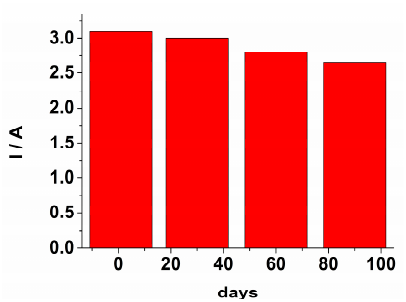
Figure 12. The sensor’s response towards H 2 O 2 at various interval times over a period of 90